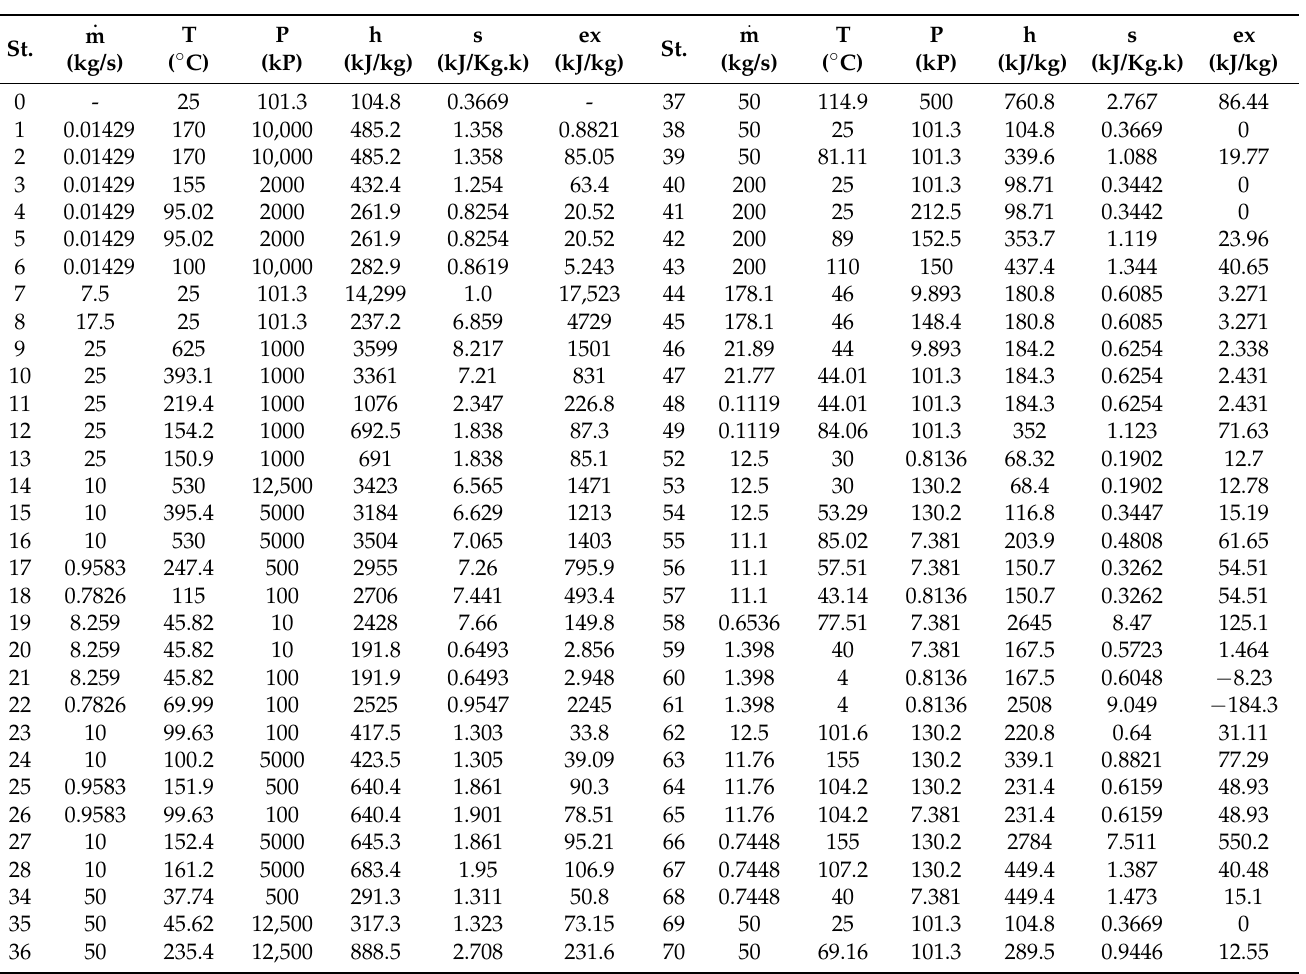
Thermodynamic properties at each state of the proposed system under the basic design conditions.